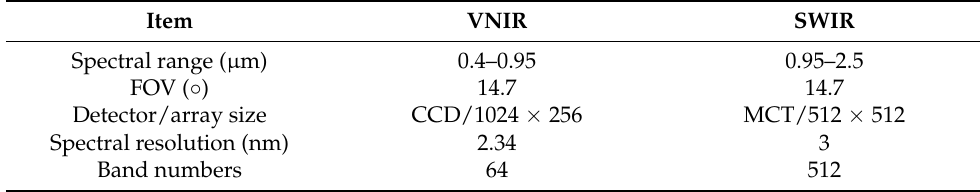
Table 3. Main FAHI parameters (VNIR; SWIR; CCD; and MCT).